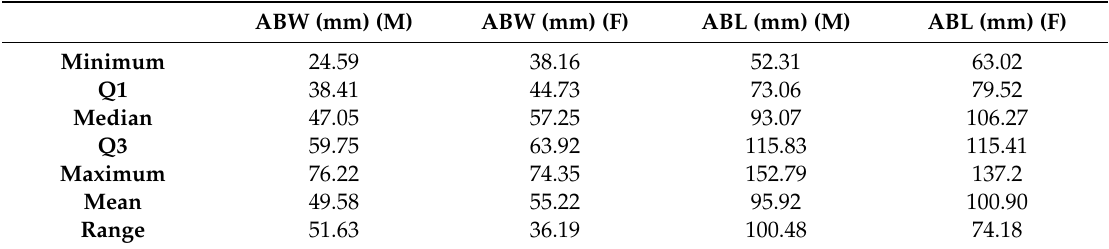
Table A2. Minimum, median, average and maximum values of ABW and ABL regarding the spiny lobsters’ measurements, from the Thermaikos Gulf,